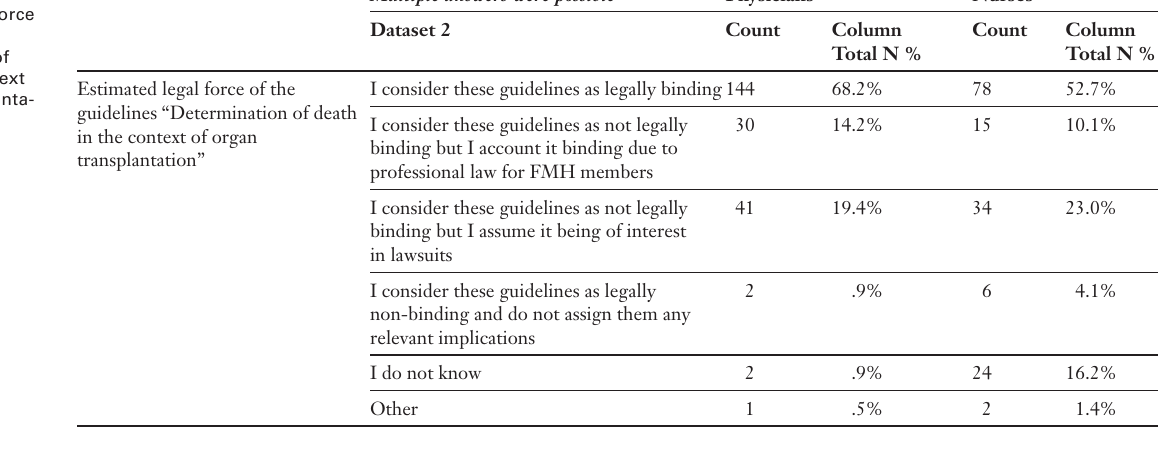
Information sources for the guidelines “Care of patients in the end of